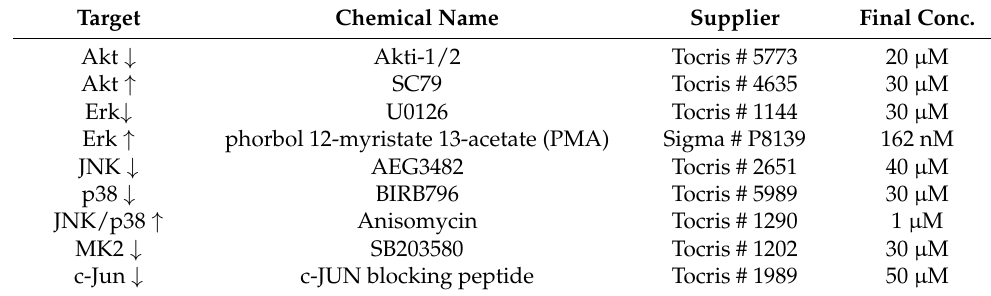
Table 1. Host cell kinase inhibitors and activators used for growth